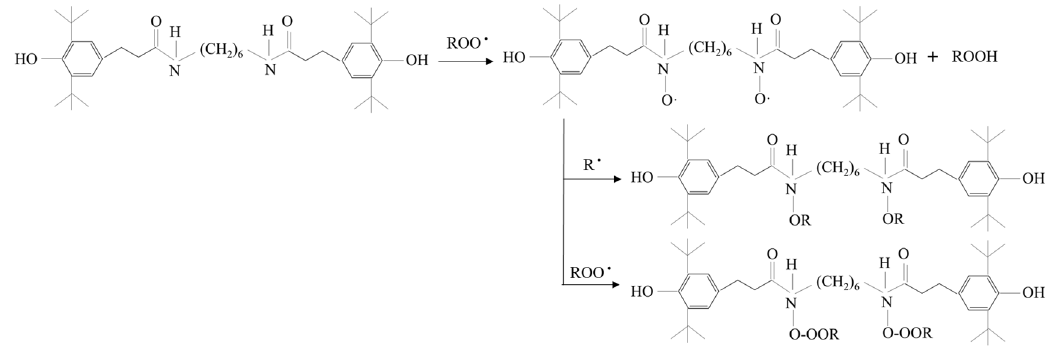
Table 3. Physical information of asphalt.